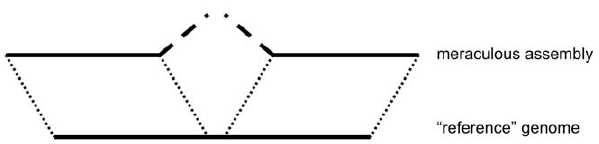
Figure 5. Differences between E.coli meraculous and reference sequence identify transposon insertion. Bottom line shows portion of the Genbank reference genome for E. coli str. K-12 substr. MG1655 produced by Sanger sequencing and directed finishing strain [27]. Top shows alignment of the de novo meraculus contigs to reference sequence. Solid lines agree perfectly. Angled dashed lines represent unaligned meraculous contig-ends that correspond to the beginning and end of a transposable element. All short-read data supports the meraculous sequence, indicating either insertion of the transposon in the Illumina-sequenced lineage, or an error in the